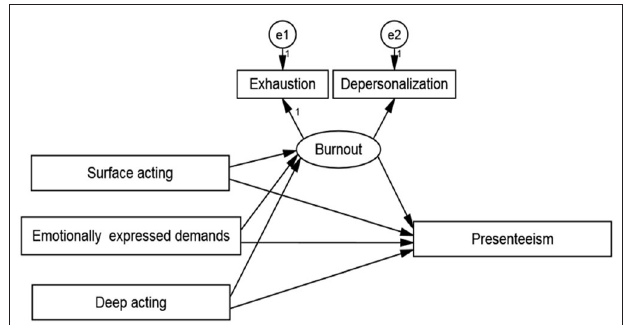
FIGURE 3 | The structural equation model.